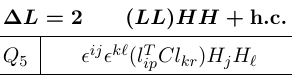
Table 1 . Dimension-(cid:12)ve (cid:1) L = 2 operator Q 5 in SMEFT. There is also the Hermitian conjugate (cid:1) L = (cid:0) 2 operator Q y , as indicated by + h : c : in the table heading. Subscripts p and r are 5 weak-eigenstate indices.